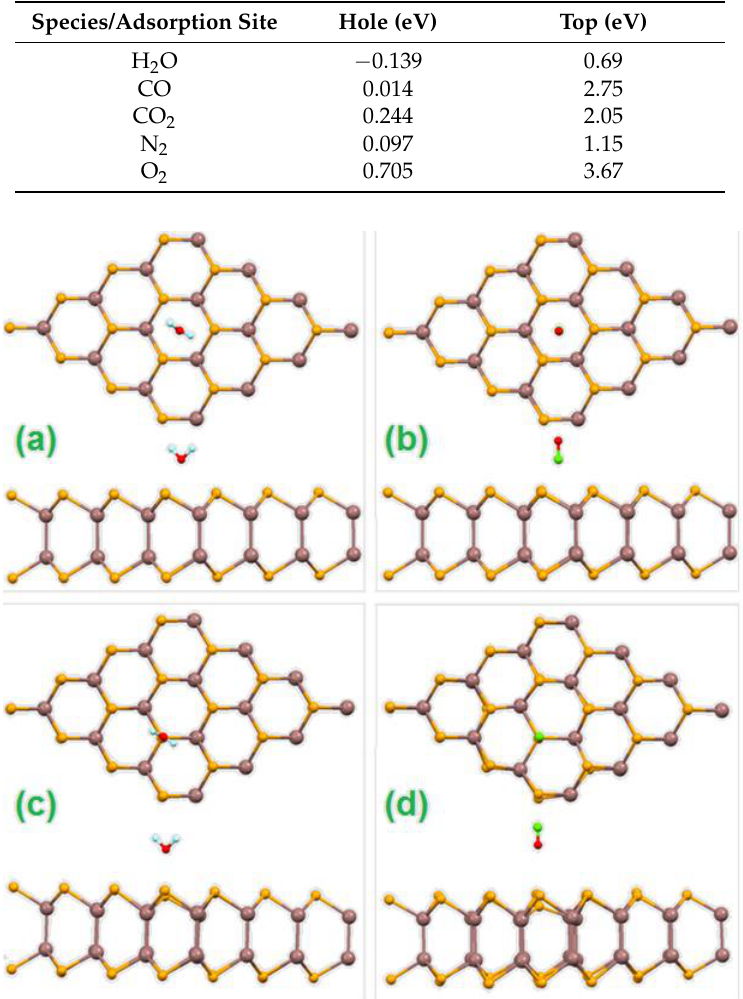
Figure 9. Top and side views of the geometrical structure of InSe monolayer in the case of adsorption of H 2 O ( a , c ) and CO ( b , d ) molecules over hole sites ( a , b ) and top sites ( c , d ) with respect to Se atoms. Reproduced with permission from Ref. [20]. Copyright Royal Society of Chemistry, 2016.